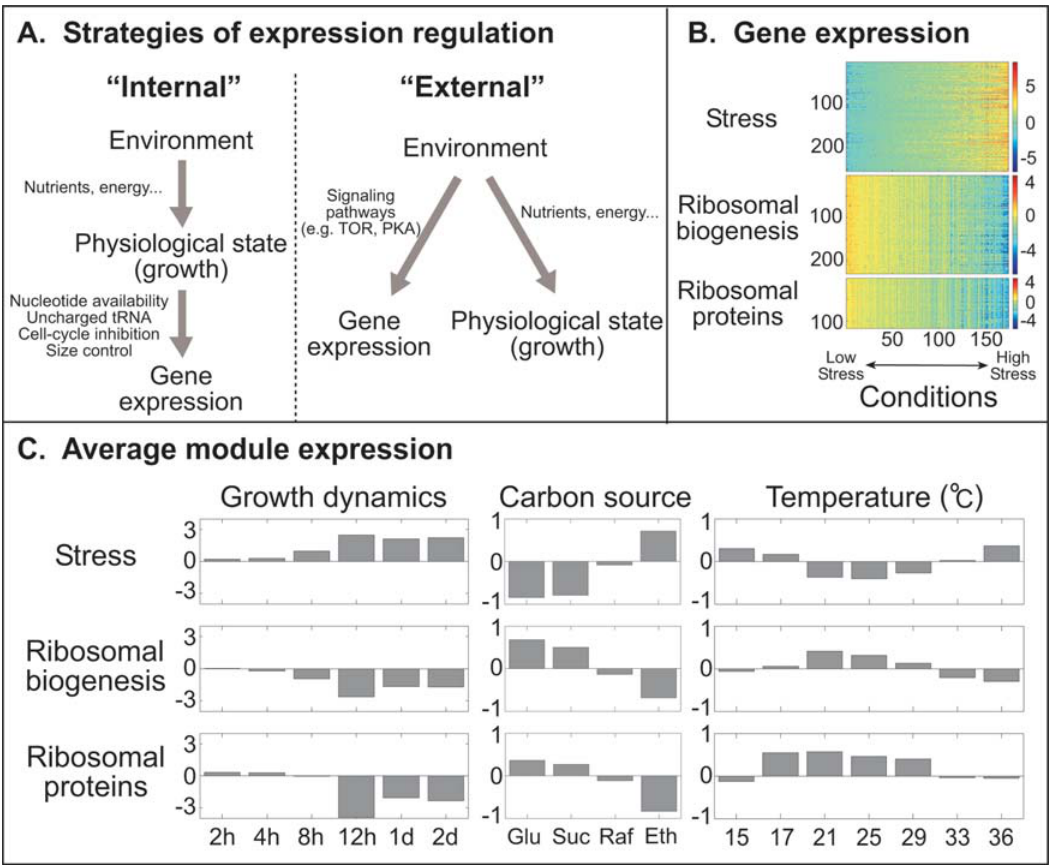
Figure 1. (a) Environmental versus growth dependent modulation of gene expression. Gene expression can be modulated by direct signaling pathways which sense the environmental cues. Alternatively, it can be regulated by internal cues which are coupled directly to cell growth. In this study we characterize the relative contribution of external vs. internal sensing to the regulation of gene expression. (b,c) Expression profile of ESR modules during growth at different environmental conditions (reported in [25]; see table S1 for the list of genes). (b) The colormap represents the log 2 -expression-ratio of the respective gene module. The conditions are sorted by the average expression level of the stress module. (c) Average log 2 - expression-ratio of the respective gene module under the indicated condition. Stress-induced genes are activated, while ribosomal biogenesis and RP genes are repressed under conditions associated with slow growth (e.g. non-optimal temperatures, non-fermentable carbon source, or stationary phase).